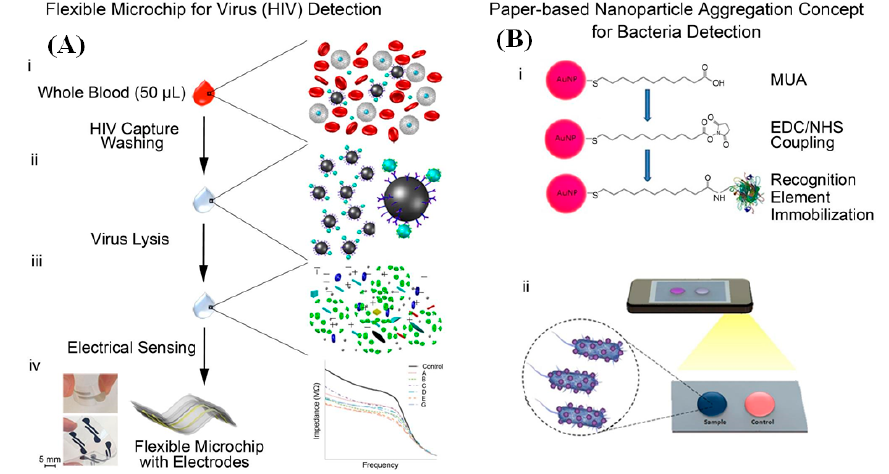
Figure 3. ( A ) Schematic of the flexible polyester film-based electrical sensing platform for HIV detection, including the capture of HIV through the use of anti-gp120 antibody coated magnetic beads, washing and lysis steps, and measurement of electrical impedance; ( B ) Detection of bacteria on cellulose paper, using a smartphone, based on nanoparticle aggregation assay. The following schematics depict the gold nanoparticle surface modification steps and the resultant aggregation assay which is detected by using a smartphone [71].